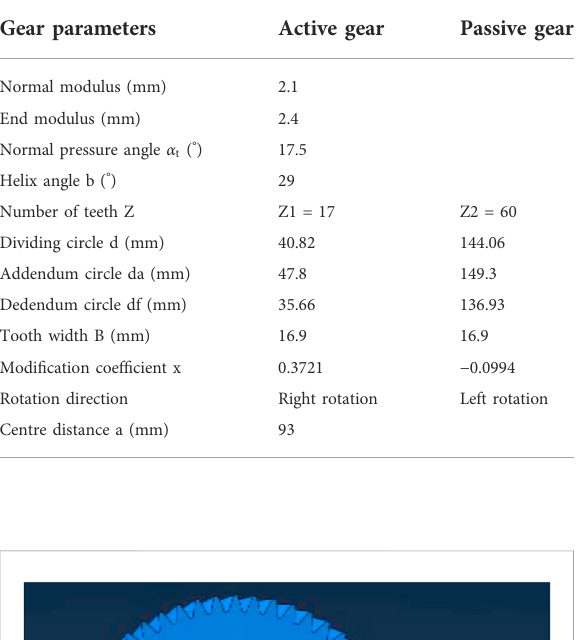
TABLE 1 Gear parameters.